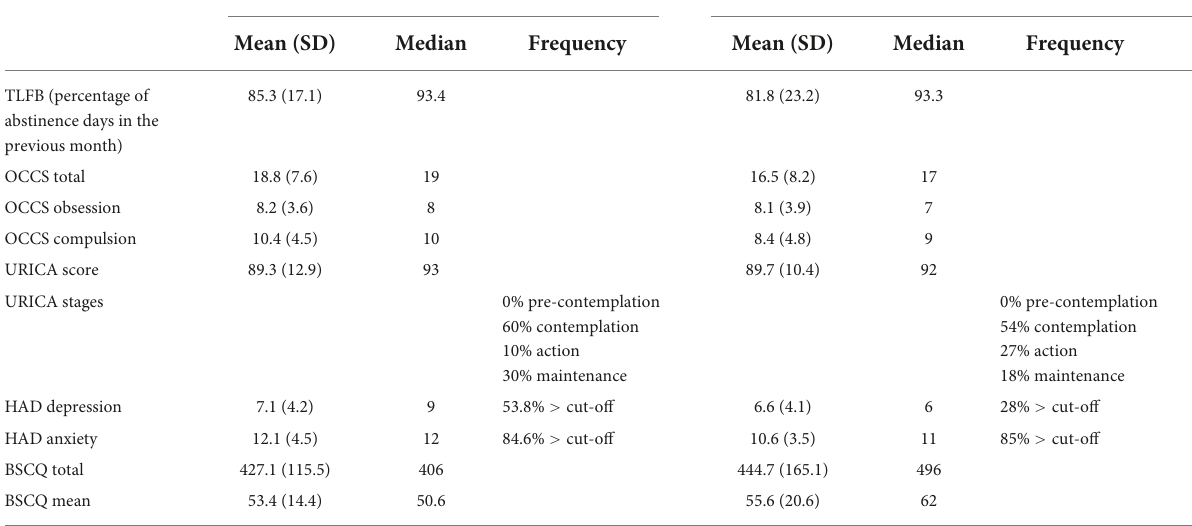
TABLE 3 Completers evaluation.